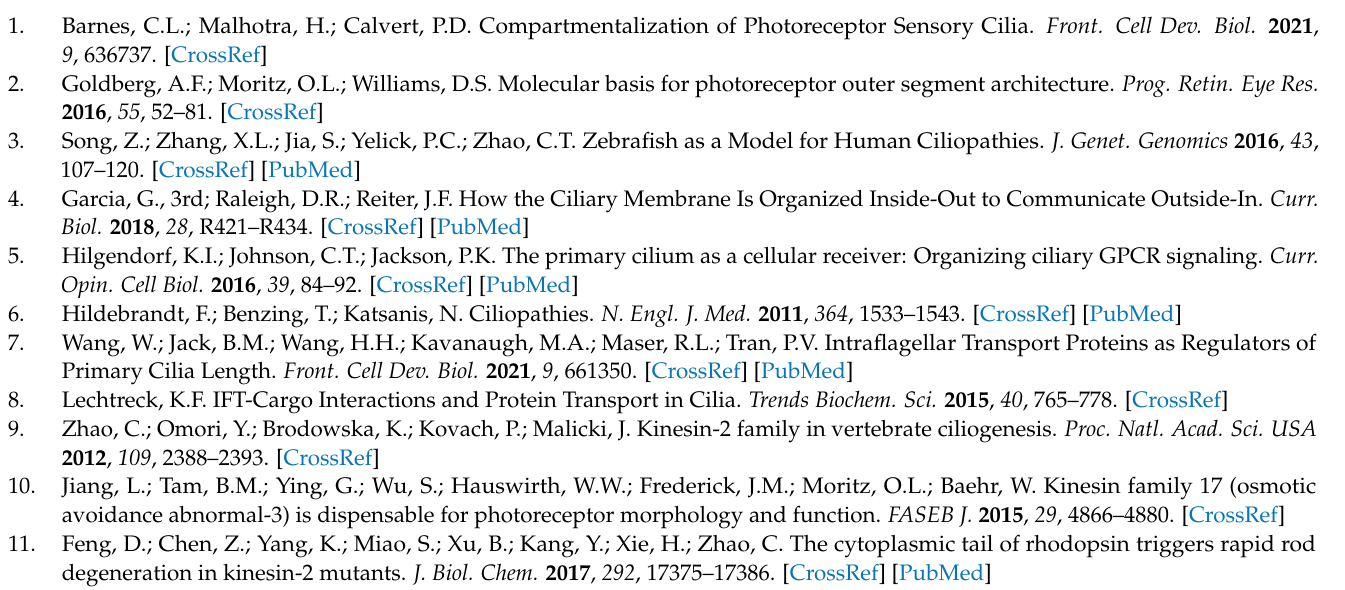
defects in 3dpf ift74 mutants, Figure S3: Phenotypes of photoreceptor outer segments in ift74 mutants, Figure S4: Rapid photoreceptor degeneration in ift88 and kif3a mutants, Figure S5: Opsin